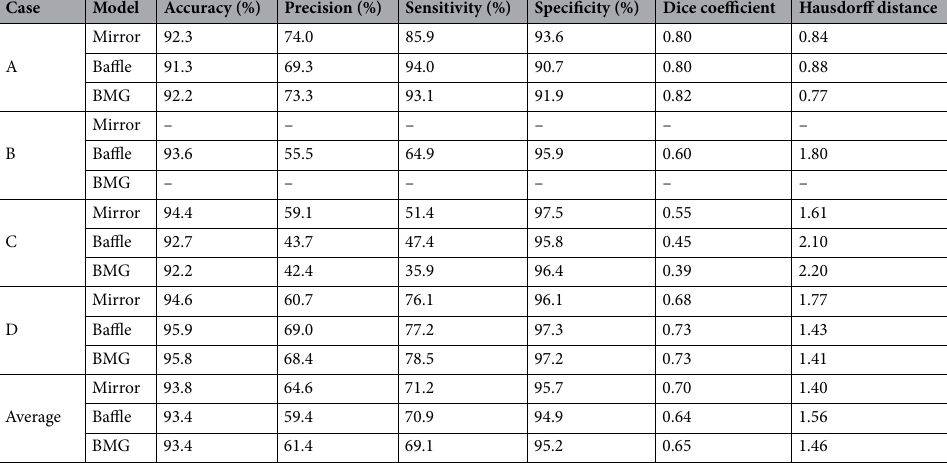
Table 3. Comparison of designed model created by using mirror, baffle planner and BMG methods. Average evaluation values of accuracy, precision, sensitivity, specificity, Dice coefficient and Hausdorff distance derived from cases A, C and D. An evaluation of case B created from baffle planner method, compared with the reference.